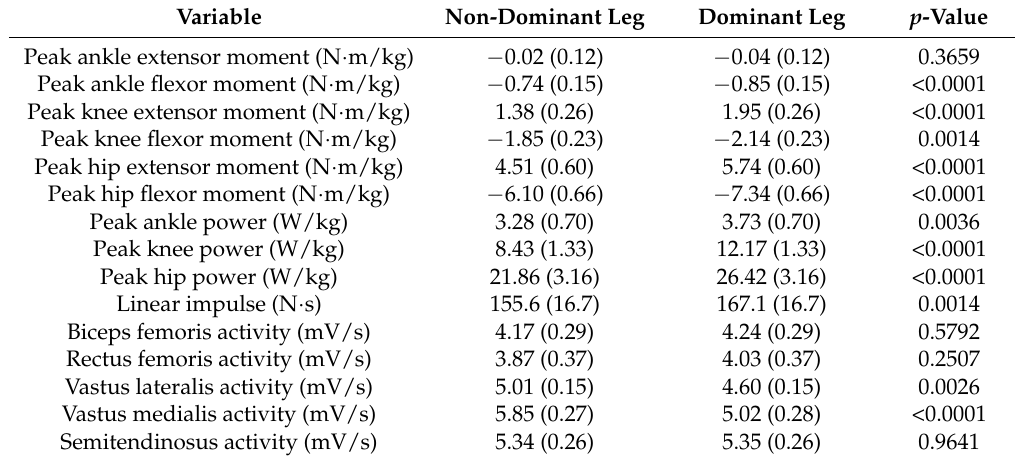
Table 2. Effect of leg dominance on variables of interest (standard error values are listed in parentheses). Variable Non-Dominant Leg Dominant Leg p